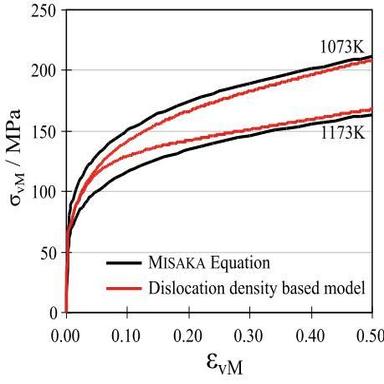
Flow curves for two selected temperatures. Comparison of the prediction by Eq. to the behavior of the employed Crystal Plasticity (CP) model (see Section and. Figure adopted from.